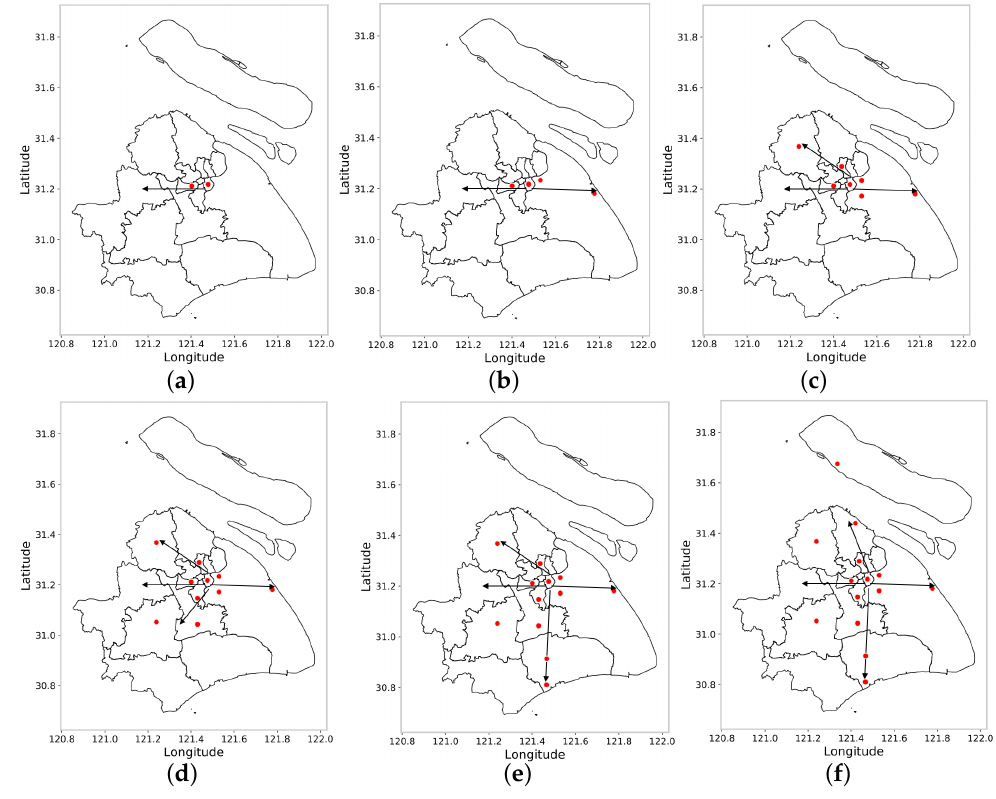
Figure 4. Site selection targets of ( a ) 2, ( b ) 4, ( c ) 7, ( d ) 10, ( e ) 12 and ( f )